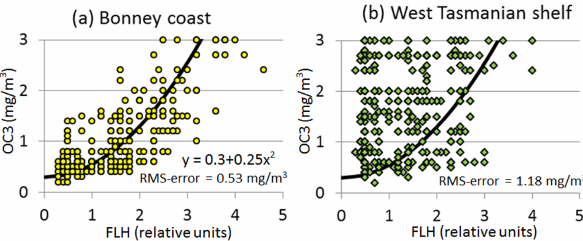
Figure 9. Correlation between OC3 values and normalised fluores- cence line height (FLH), multiplied by a factor of 100, for (a) the Bonney coast and (b) the western Tasmanian shelf for the period from 1 January 2005 to 31 March 2014. Solid lines show a quadratic regression corresponding to a root mean square error (RMSE) of 0.53mgm − 3 for the Bonney coast data. Data source: NASA (Gio-